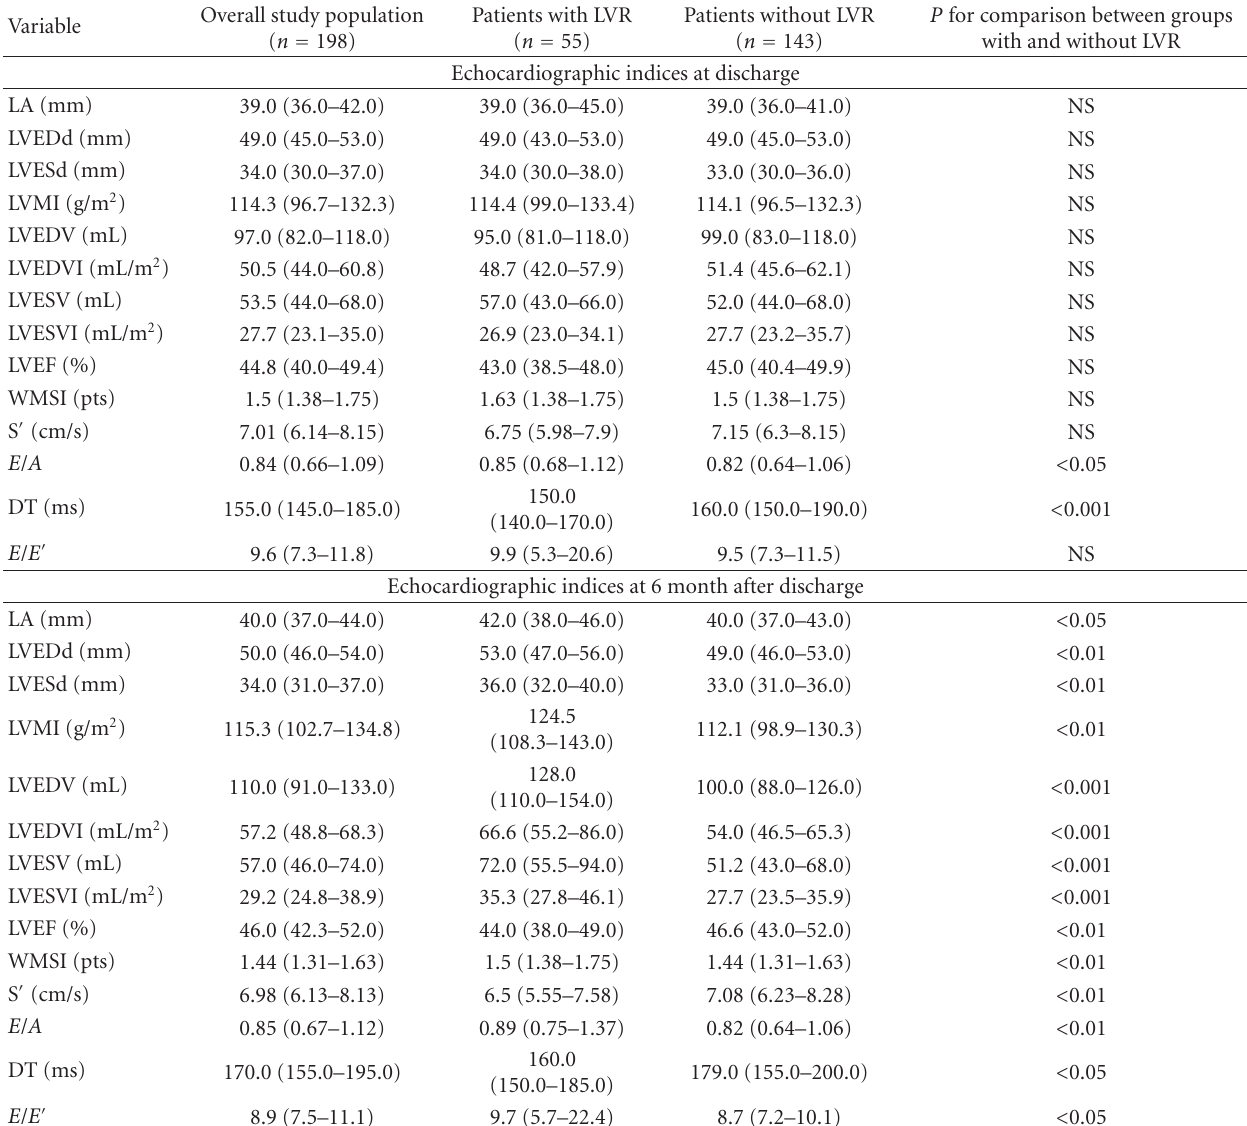
Table 3: Echocardiographic characteristics of the study population. Echocardiographic indices are derived from 2D, Doppler echocardio- graphy, and tissue Doppler echocardiography at hospital discharge and at 6 month after discharge,